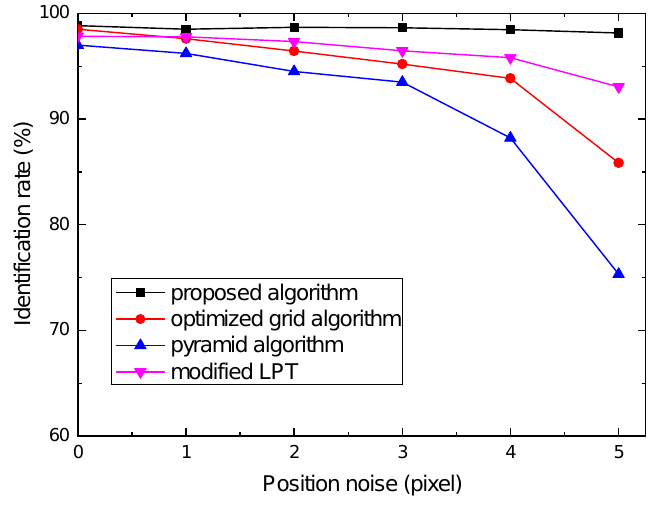
Figure 5. Identification rate versus position deviation.